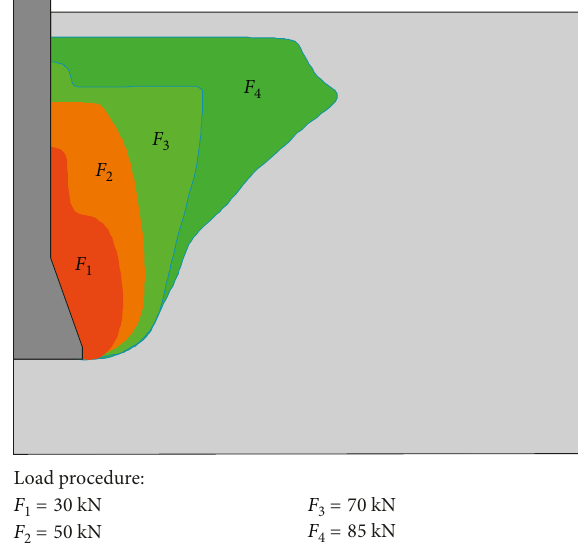
Figure 23: Plastic zone development of the belled pier